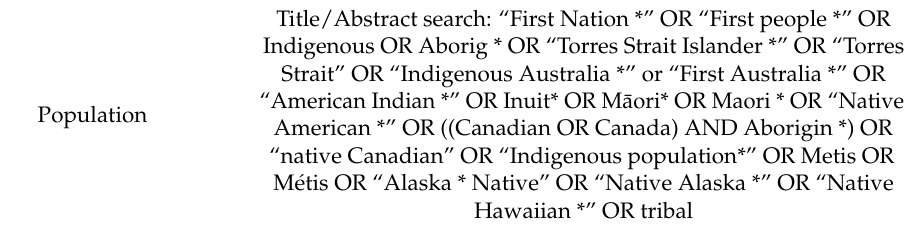
Table 1. Medline & Pre-Medline Search